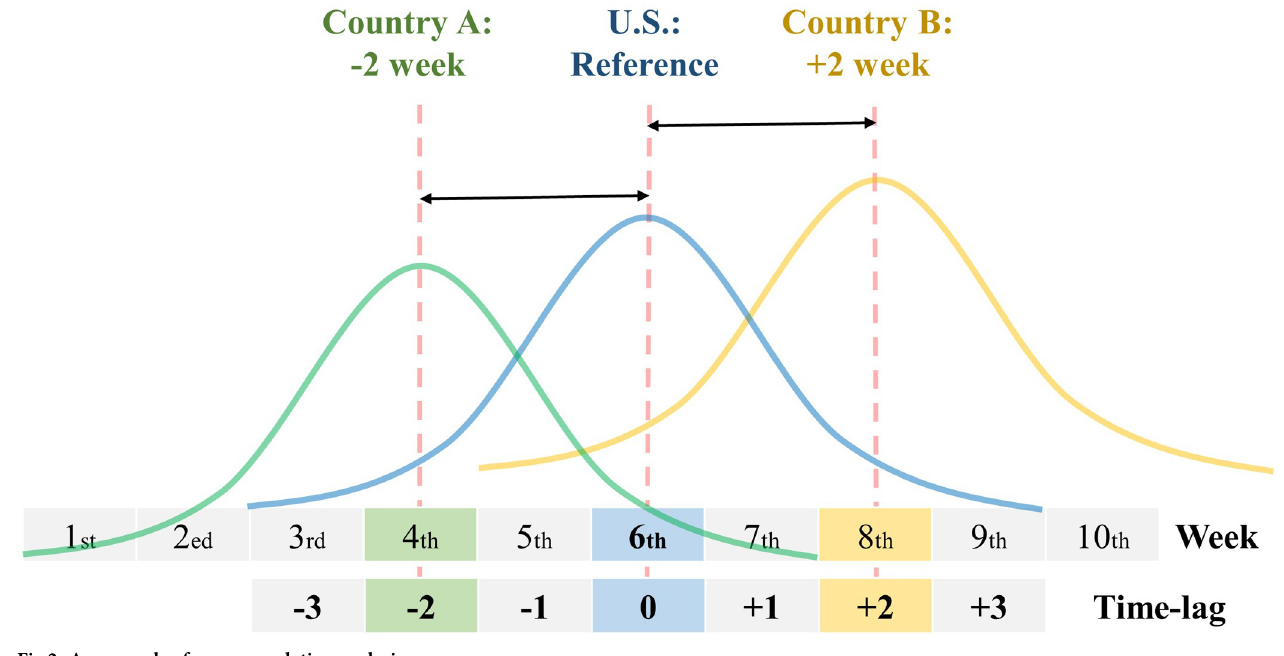
Fig 2. An example of cross-correlation